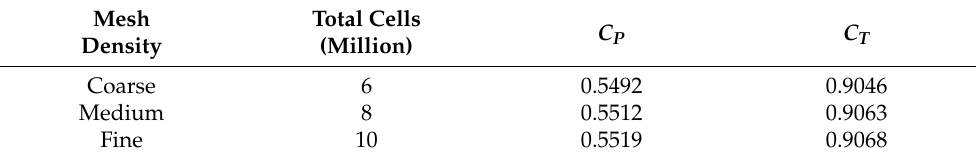
Figure 5. Mesh distribution: ( a ) volume mesh; ( b ) surface mesh. Table 1. Mesh independence assessment.